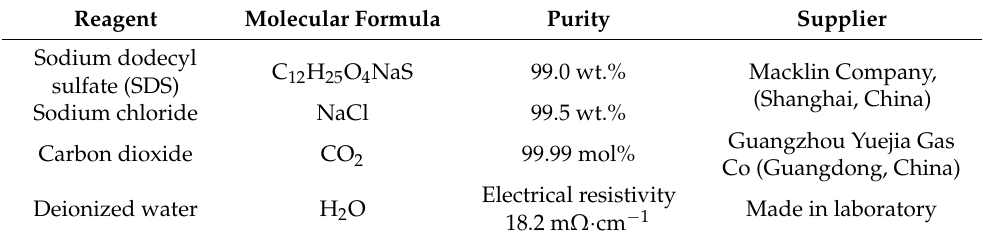
Table 1. List of experimental